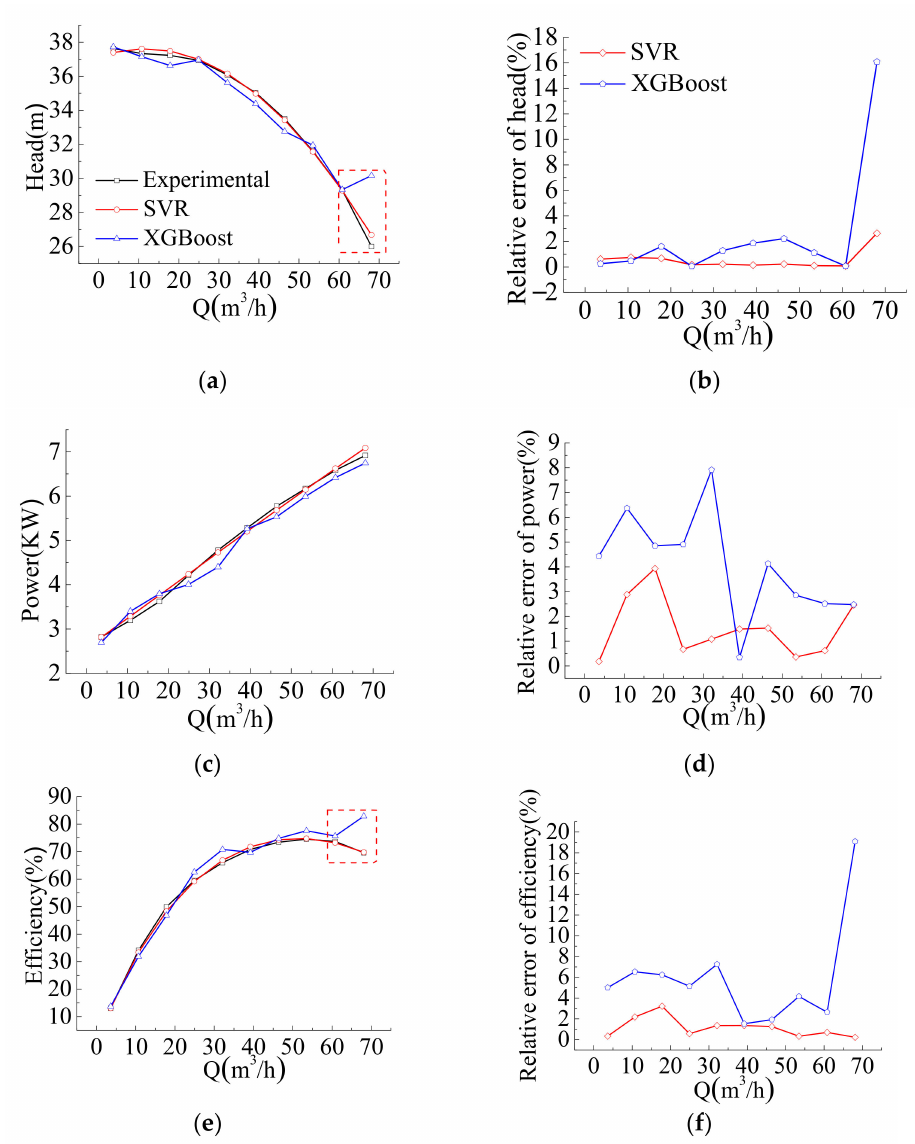
Figure 10. Comparison of performance prediction models for single-stage single-suction centrifugal pumps with a specific speed of 90.7. ( a – c ) are the predictions of head, power and efficiency; ( d – f ) are the absolute relative error of head, power and